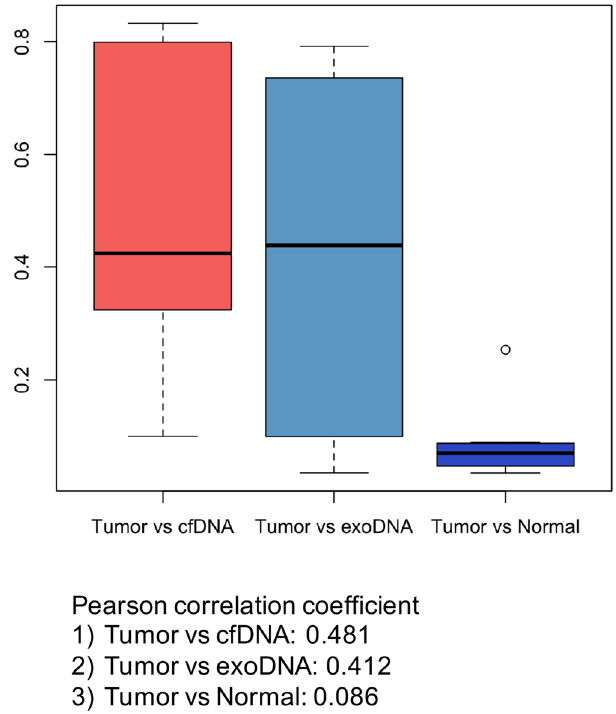
Figure 4. Similarities of copy number aberration between samples. While a mean Pearson correlation coefficient between tumor and normal samples was 0.086, those between tumor and cfDNA, and tumor and exoDNA, were 0.481 and 0.412,